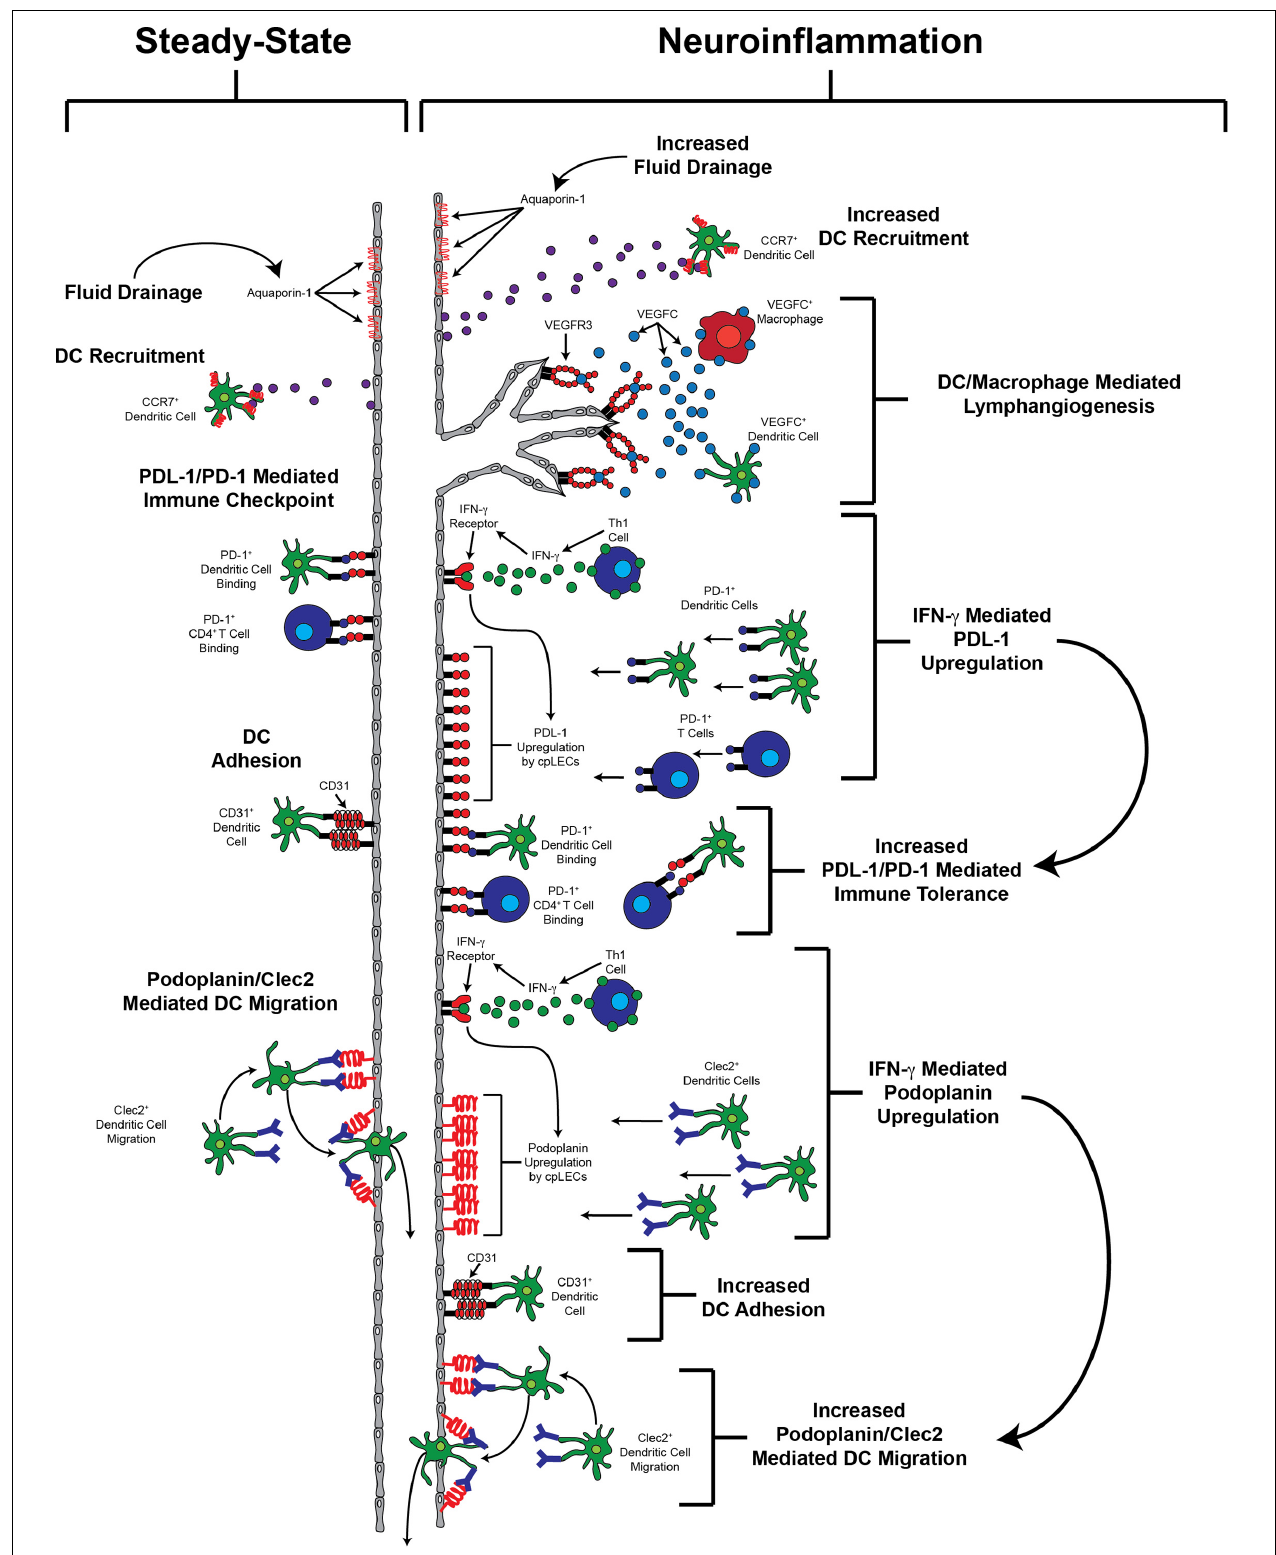
FIGURE 1 | Potential functions of lymphangiogenic